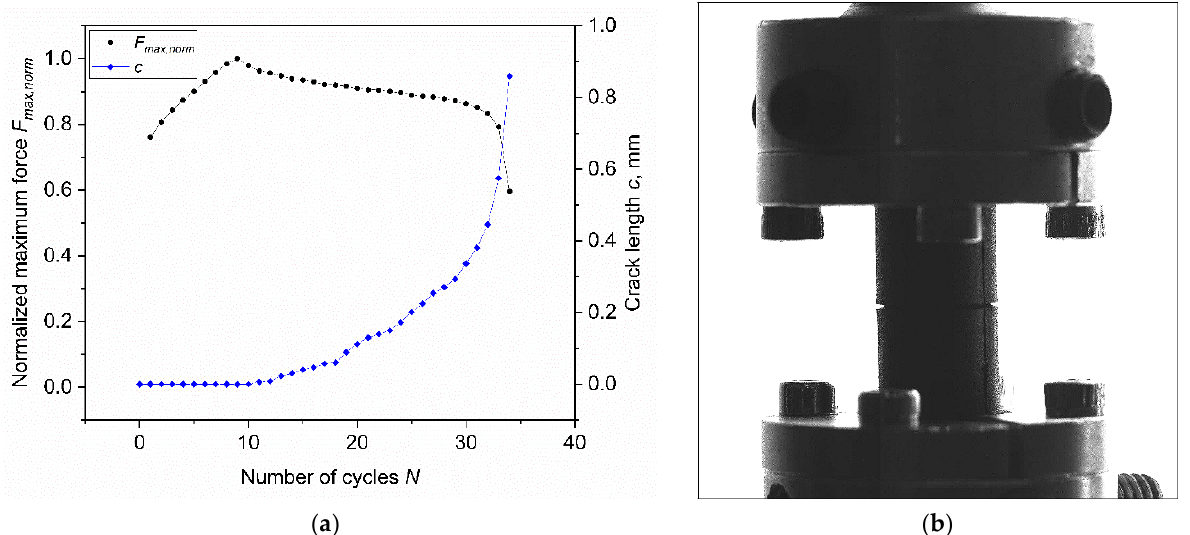
Figure 13. ( a ) Normalized maximum force (circles) and crack length (diamonds) against number of cycles for CRB specimens obtained from axisymmetric dumbbell specimens of CB filled NBR. ( b ) Picture of the tested CRB at N = 30; on both sides, the crack opening can be recognized. The test was performed at the maximum strain of 50% at a frequency of 4 Hz and a load ratio R ε of 0.5.